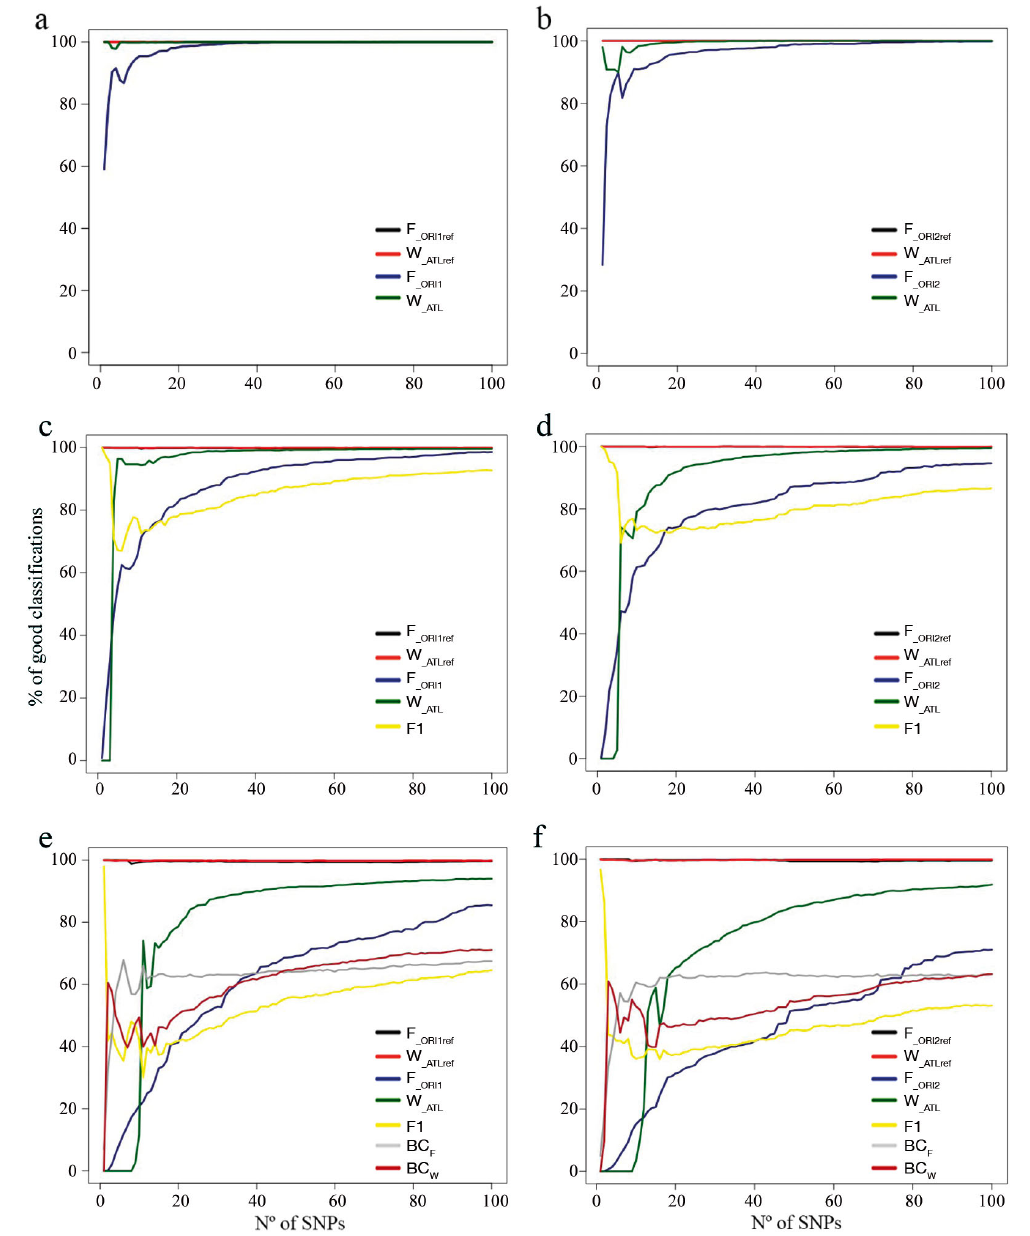
Fig. 7. Classification success of turbot pertaining to simulated populations and hybrid categories using up to 100 SNPs. F _ORI1 : farmed origin 1; F _ORI2 : farmed origin 2; W _ATL : pure wild population from the Atlantic region; F1: first generation of hybrids be- tween wild and farmed; BC F : backcross between F1 and the respective farmed origin; BC W : backcross between F1 and the pure wild population; ref: wild and farmed reference genotypes; F, W, F1, BCs: genotypes generated by simulation for testing. Different scenarios were tested: (a,b) wild and farmed; (c,d) wild, farmed and F1 hybrid; (e,f) wild, farmed, F1 and BCs; (a,c,e) tests with F _ORI1 ; (b,d,f) tests with F